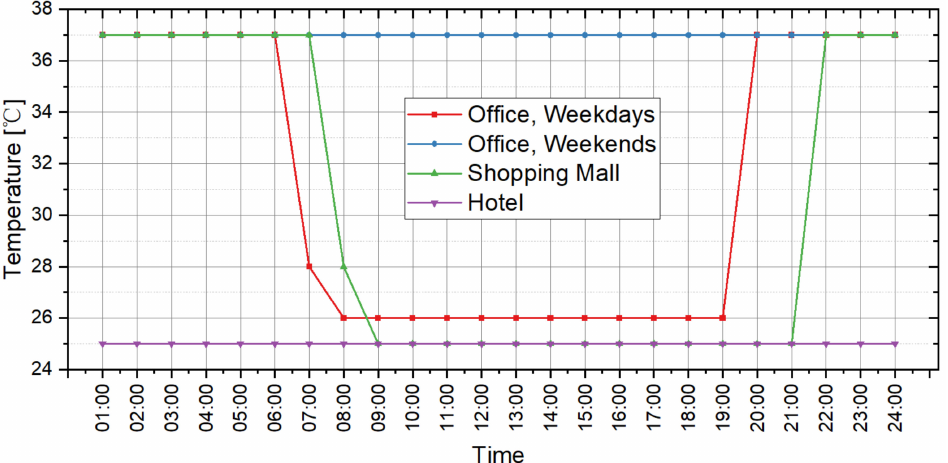
Figure 3. Indoor design temperature in summer.